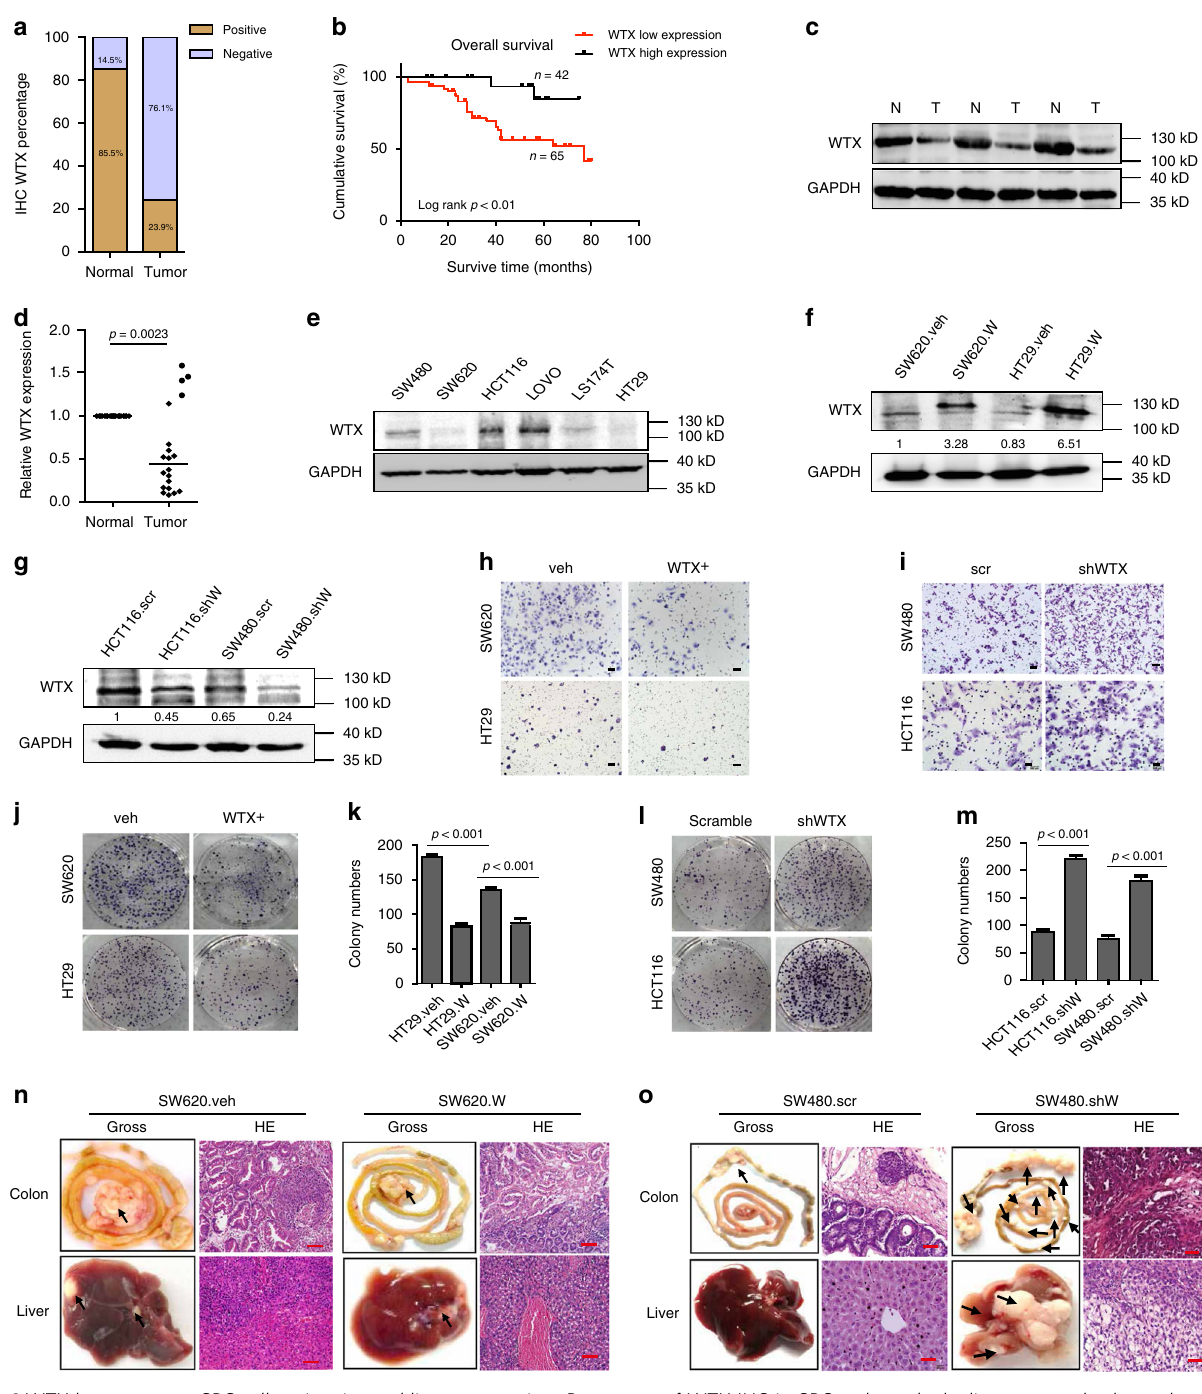
Fig. 1 WTX loss promotes CRC cells, migration and liver metastasis. a Percentage of WTX IHC in CRC and matched adjacent normal colorectal mucosa tissues. b Kaplan – Meier survival analysis of CRC patients with WTX high or WTX low expression. c Imunoblotting (IB) analyzes the WTX expression in human CRC tumor (T) and matched adjacent normal mucosa (N) tissues. d qRT-PCR analyzes WTX mRNA level in human CRC tumor and matched adjacent normal mucosa tissues. ** p = 0.0023, mean ± SEM. Two-tailed Student ’ s t -test. e IB analyzes WTX expression in CRC cell lines. f , g IB analyzes WTX expression in indicated cell lines. h , i Transwell analyzes the migration of the indicated cell lines. Scale bars, 200 μ m. j – m Colony formation analysis of the indicated cell lines. *** p < 0.001, mean ± SEM. Two-tailed Student ’ s t -test. n , o Gross and H&E staining observe the CRC orthotopic tumors and liver metastasis in indicated cell lines. Each arrow pointed a tumor mass. Scale bars, 20 μ m, n = 11 ( n ) and n = 8 ( o